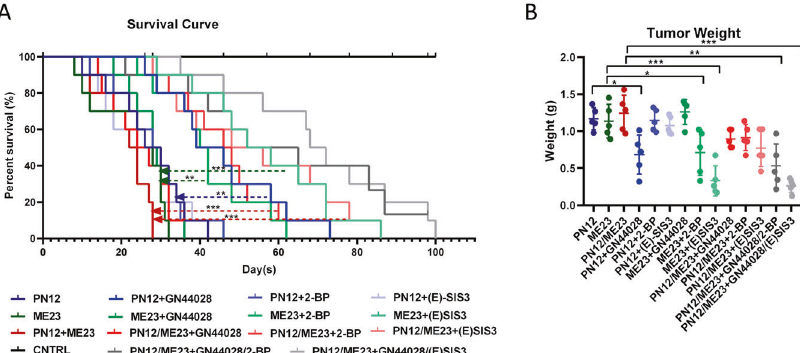
Fig. 5 In vivo therapeutic ef fi cacy of pharmacologic inhibitors of HIF-1 α and Smad3 used alone or in combination in a single subtype model and a mixed glioblastoma model. A Kaplan – Meier survival curves for mice bearing a single subtype of tumor and mice bearing a mixed orthotopic tumor with PN12 and ME23 cells that were treated with 10 mg/kg GN44028, 7.5 mg/kg 2-BP, and 15 mg/kg (E)-SIS3 alone or in combination ( n = 15 per group). Log-rank p -values were used to determine statistical signi fi cance. * p < 0.05. B Tumor weight in mice with a single subtype of tumor and mice with a mixed orthotopic tumor with PN12 and ME23 cells treated with 10 mg/kg GN44028, 7.5 mg/kg 2-BP, and 15 mg/kg (E)-SIS3 alone or in combination ( n = 5 per group) after 6